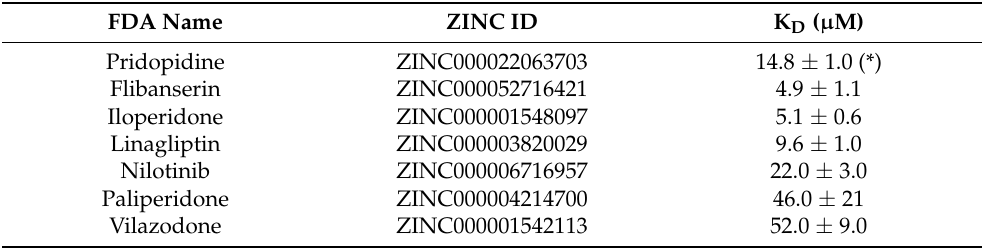
Table 3. σ 1R affinity for selected compounds and pridopidine, as a control, measured by SPR experiments.